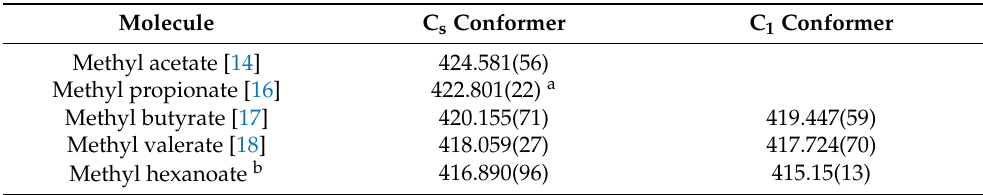
Table 3. A collection of methyl alkynoates and their respective torsional barriers of the methoxy methyl group (in cm − 1